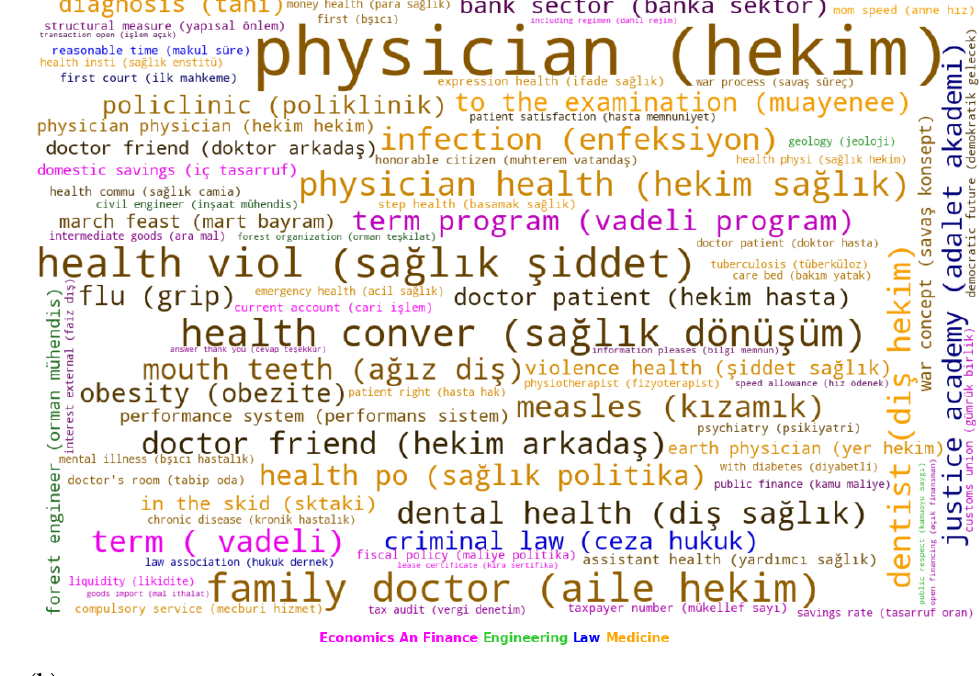
Figure 4. ( a ) Confusion matrix for profession classification with TF-IDF (word and char) _LR. ( b ) Best terms of occupation trait of